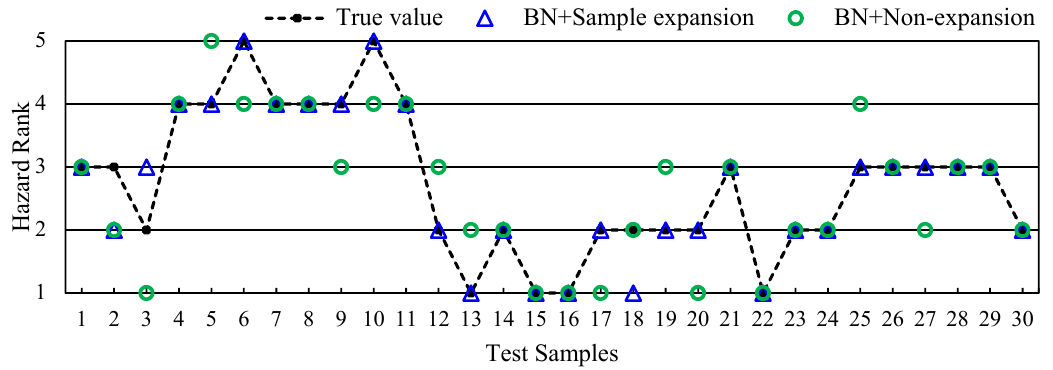
Figure 3. Assessment results of testing samples.